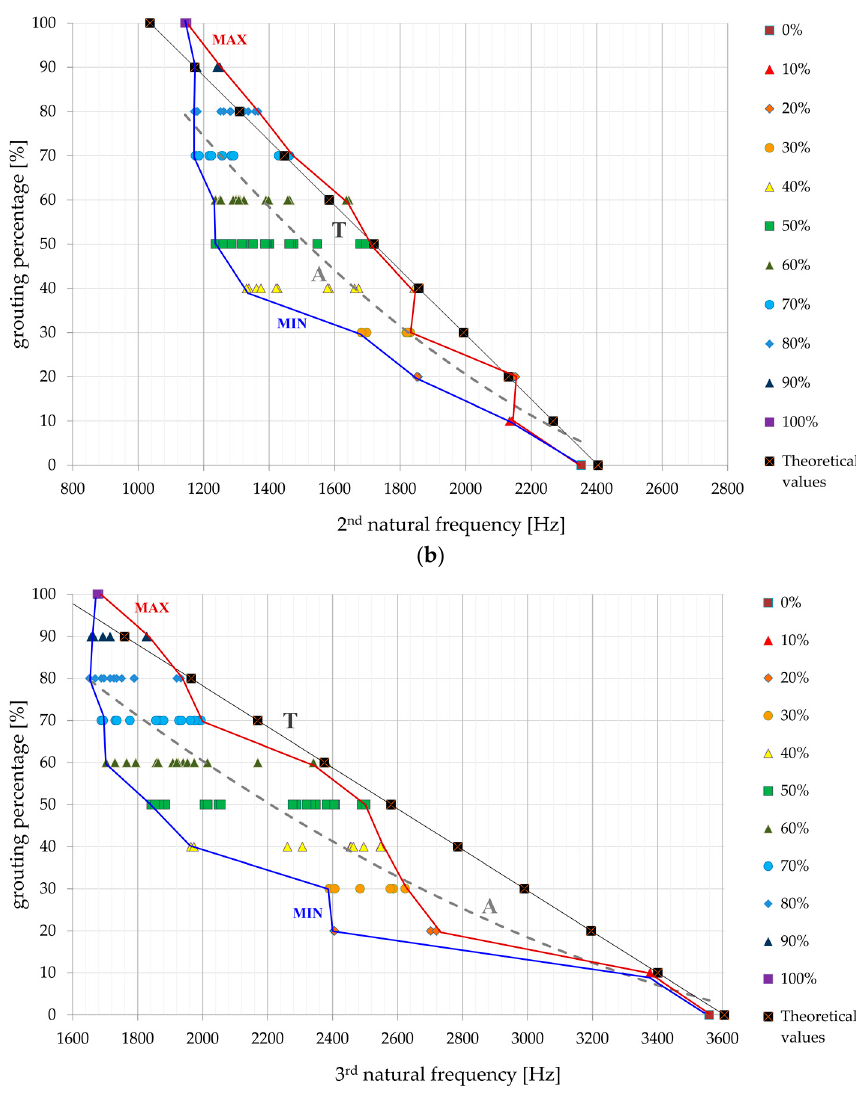
Figure 10. Regression functions for natural frequencies vs. grouting percentage for: ( a ) first, ( b ) second and ( c ) third natural frequency.